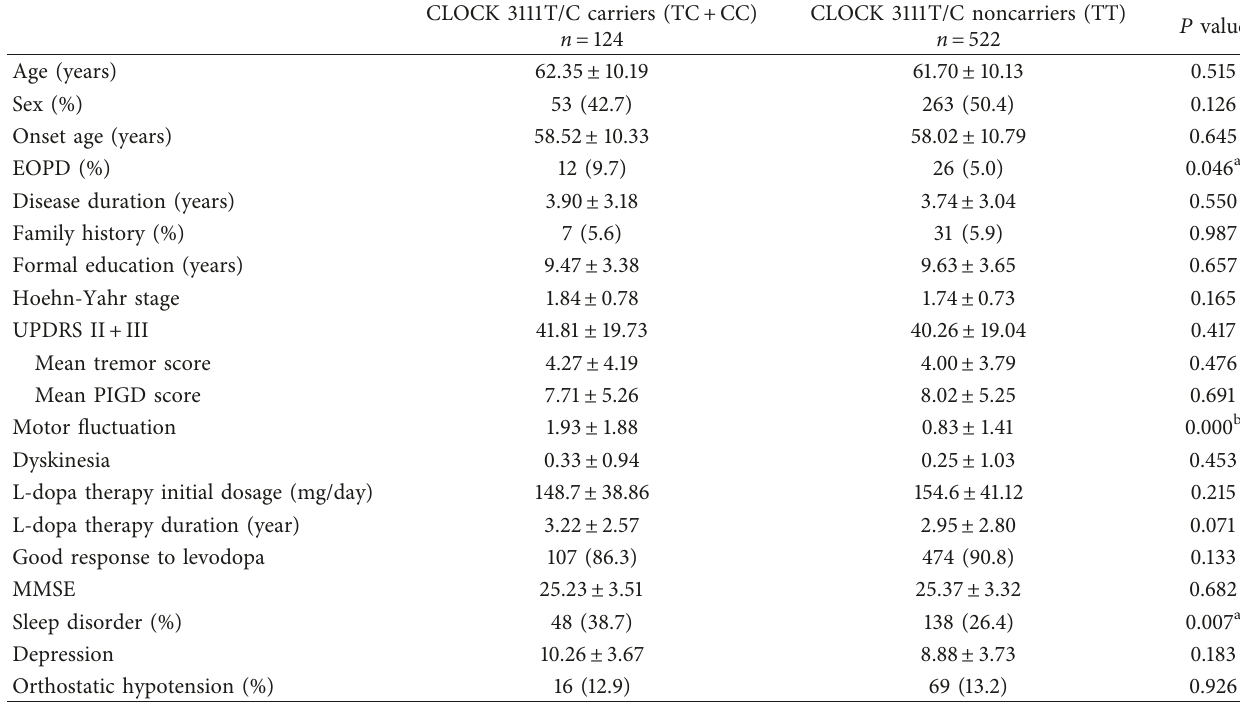
Table 1: Demographic data and clinical profiles of carriers and